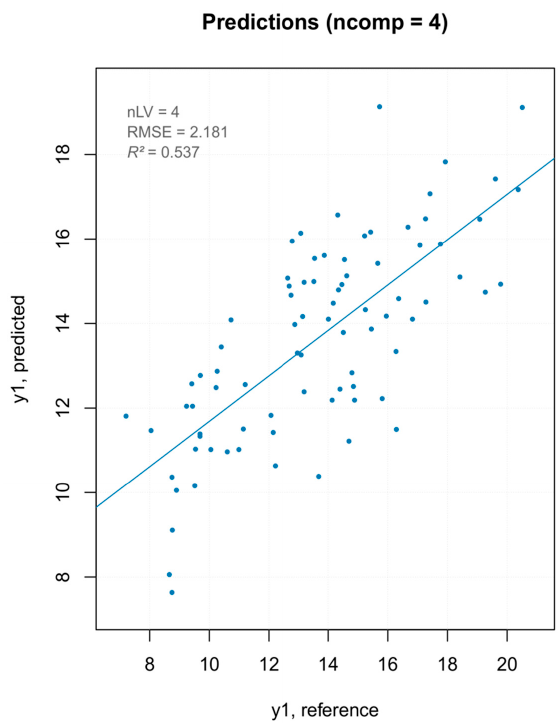
Figure 11. Extreme values removal—prediction plot for the final model for “hardness” with performance statistics. Table 2. PLS model summary for “hardness” data.